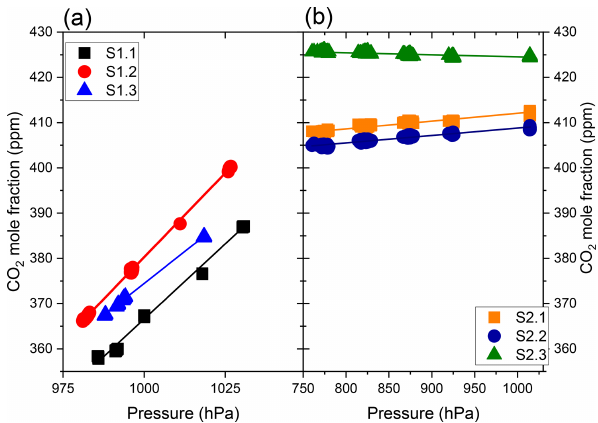
Figure 4. Linear relationship experimentally found between re- ported {CO 2 } and p for S1.1, S1.2 and S1.3 (a) and for the instru- ments S2.1, S2.2 and S2.3 (b) . Note the different p range, ranging from 972.7 to 1030hPa for the HPP3.1 instruments in the simple plastic chamber and 759.9 to 1013.25hPa for the HPP3.2 instru- ments in the PIT chamber.